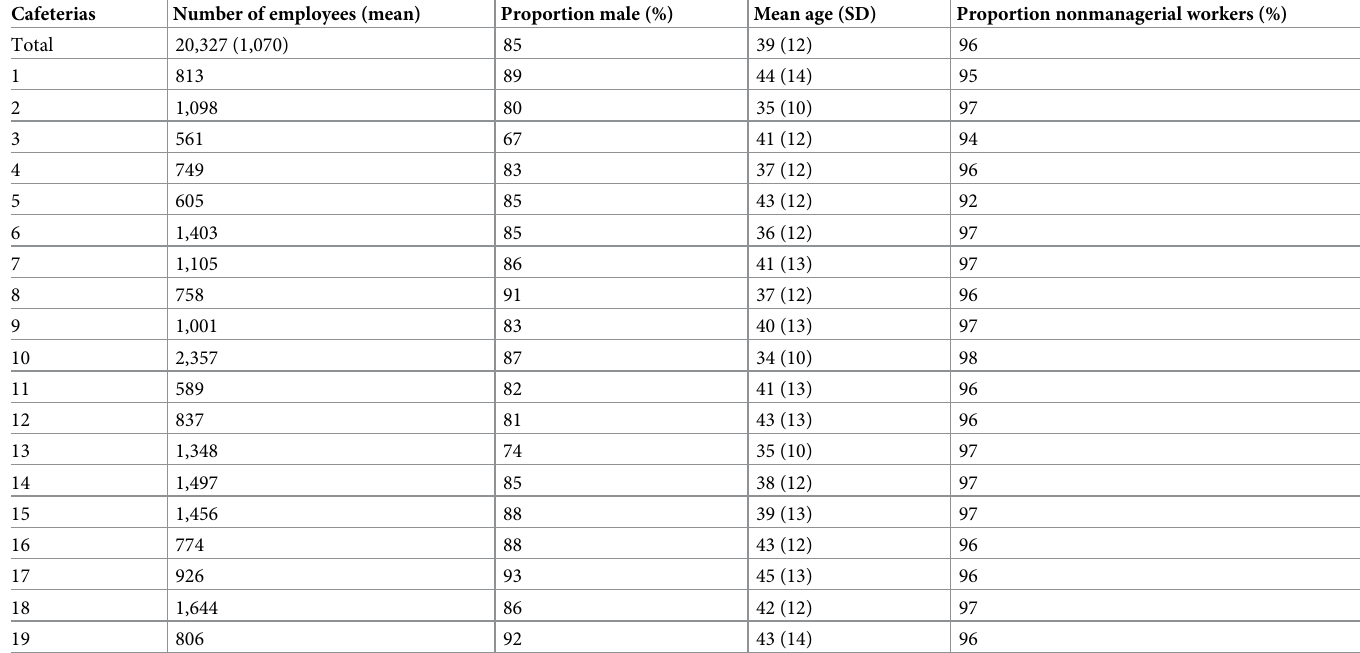
Table 1. Demographic characteristics of employees in participating